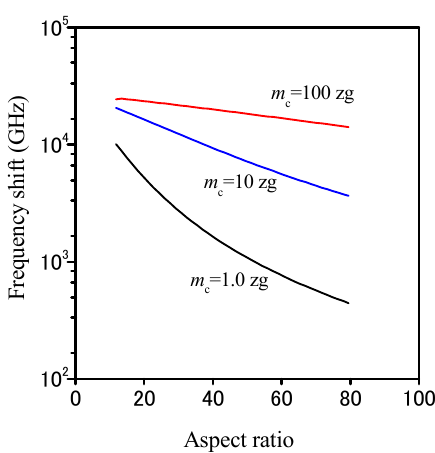
Figure 8. Relationship between the frequency shift and the aspect ratio of DLGSs for different attached mass ( (cid:2022) = (cid:2015) = 0.5